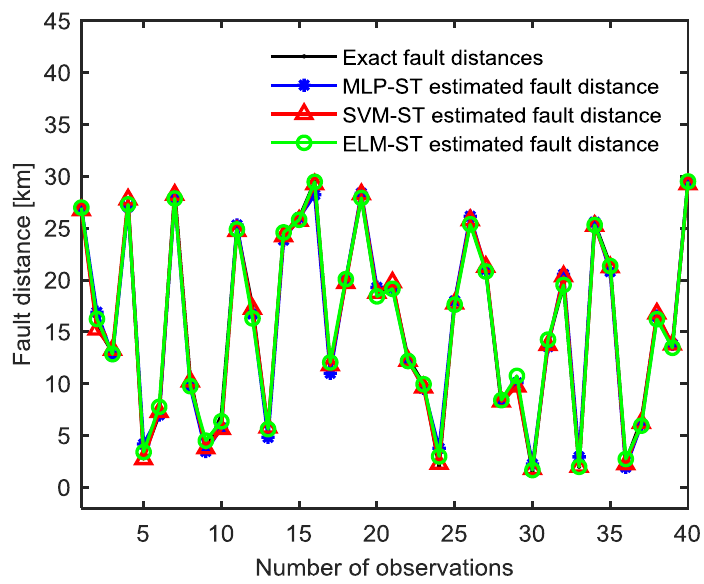
Figure 10. Comparison of the ST based optimized MLT predicted and actual fault distances, for the test dataset, in the presence of 20 dB SNR.